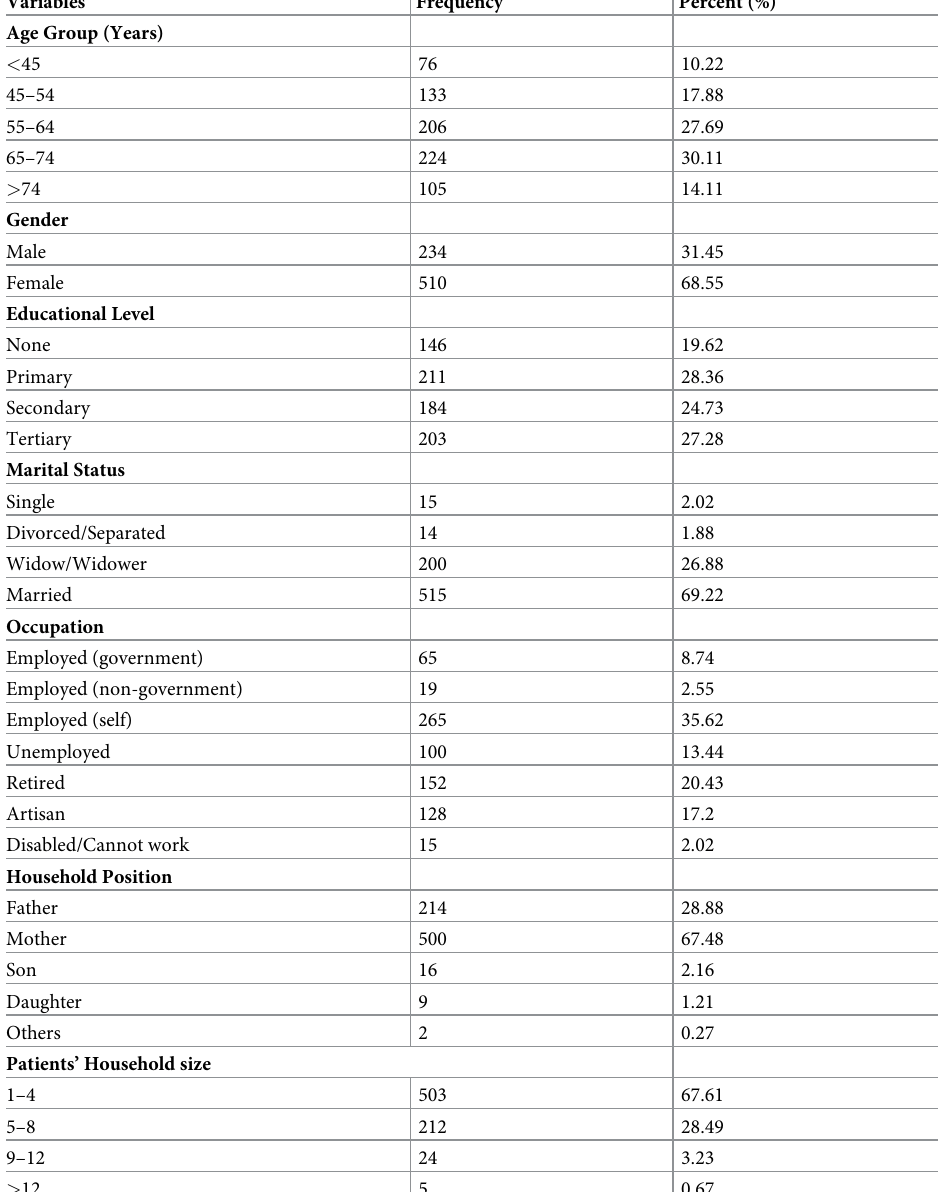
Table 1. Socio-demographic characteristics of CVDs patients accessing healthcare in public and private hospitals in Ibadan (N = 744).